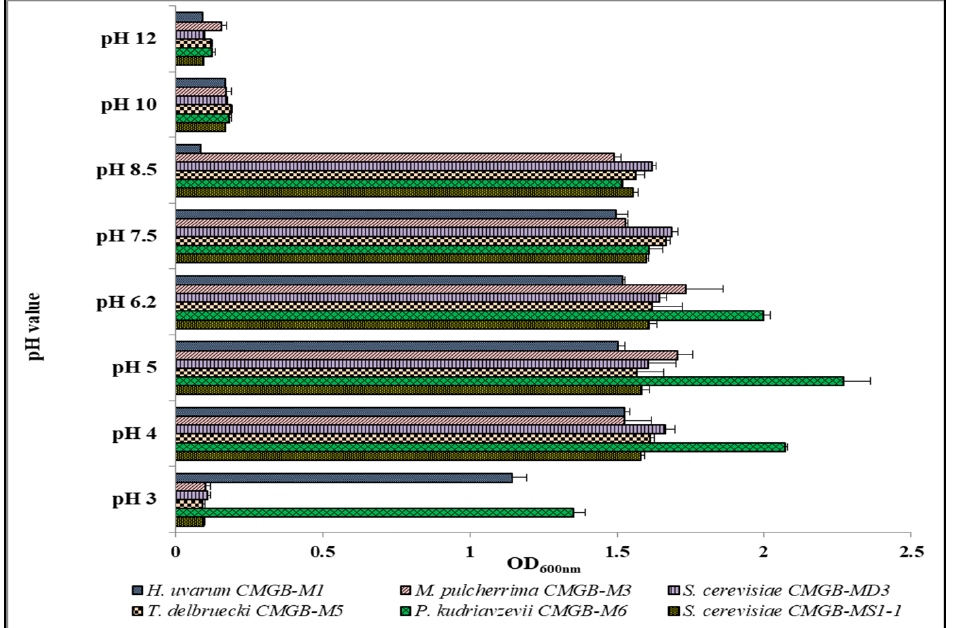
Figure 7. Growth rate of yeast strains isolated from wort sediment after 24 h of cultivation at different pH values.